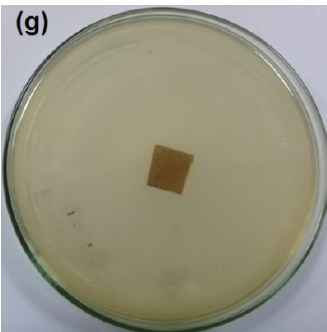
Figure 5. Images of the antibacterial test of CNFs/Pectin/PGE films against S. aureus : ( a ) blank CNFs, ( b ) CNFs + 2.5% Pectin/PGE, ( c ) CNFs + 5% Pectin/PGE, ( d ) CNFs + 7.5% Pectin/PGE, ( e )